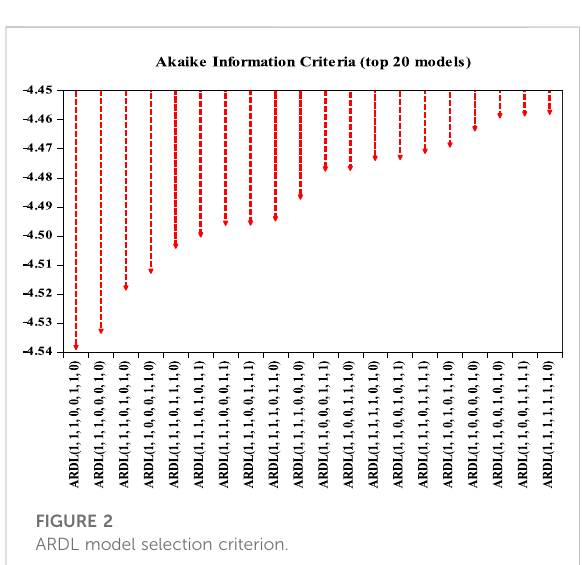
FIGURE 2 ARDL model selection